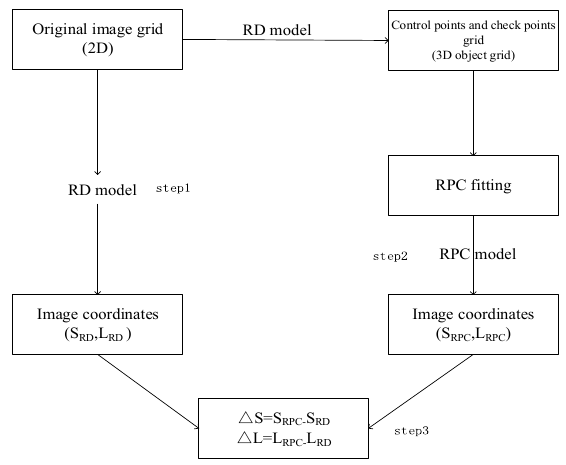
Figure 2. Flowchart of the rational polynomial coefficient (RPC) model solution process.